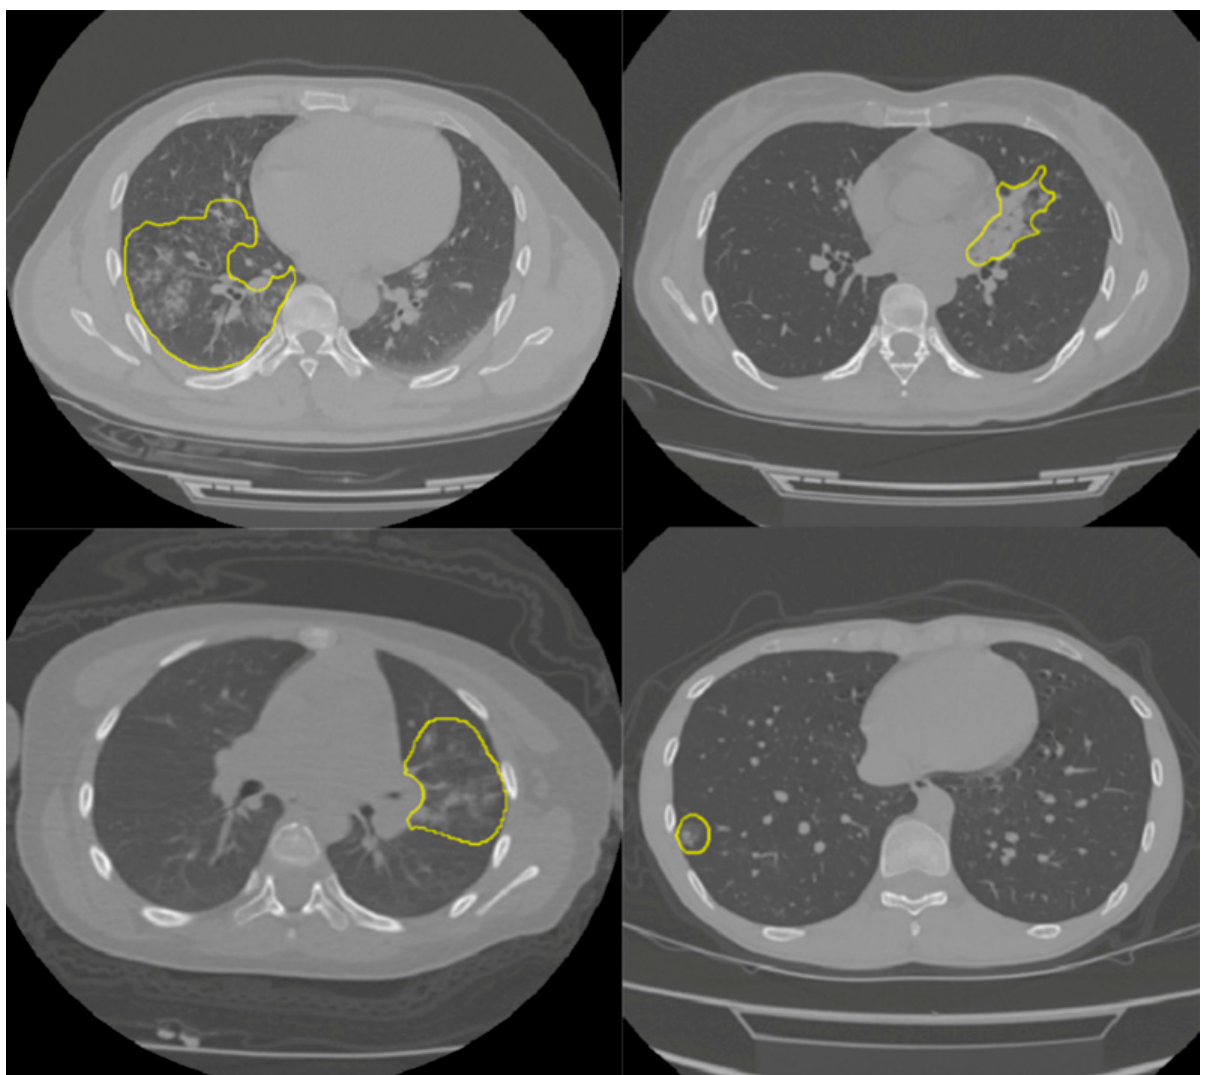
Figure 1. CT images showing the parenchyma with visible subregions (yellow) infected with COVID-19 disease.